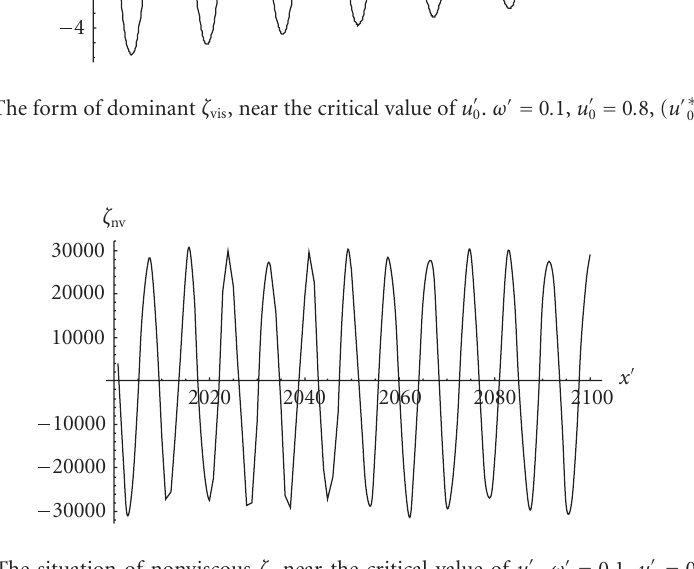
Figure 8.8. The situation of nonviscous ζ , near the critical value of u (cid:6) 0 . ω (cid:6) = 0 . 1, u (cid:6) 0 = 0 . 8, ( u (cid:6)∗ 0 . 787), ν (cid:6) = 0 .